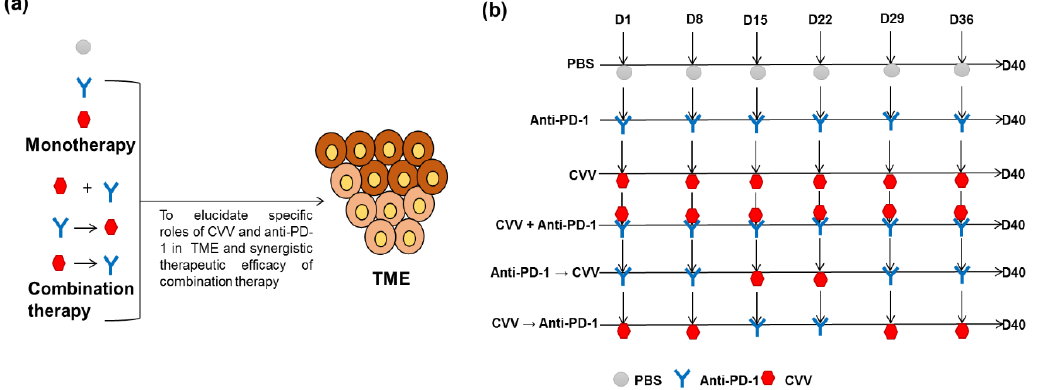
Figure 2. Monotherapy and combination therapy of CVV and anti–programmed cell death protein-1